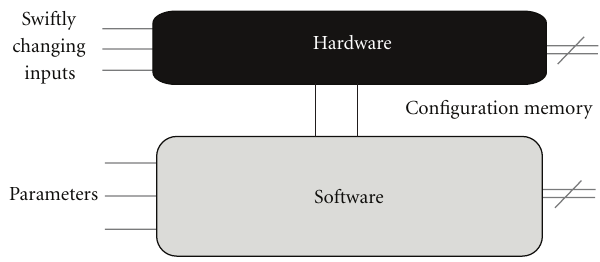
Figure 3: Hardware/software partitioning using TMAP .